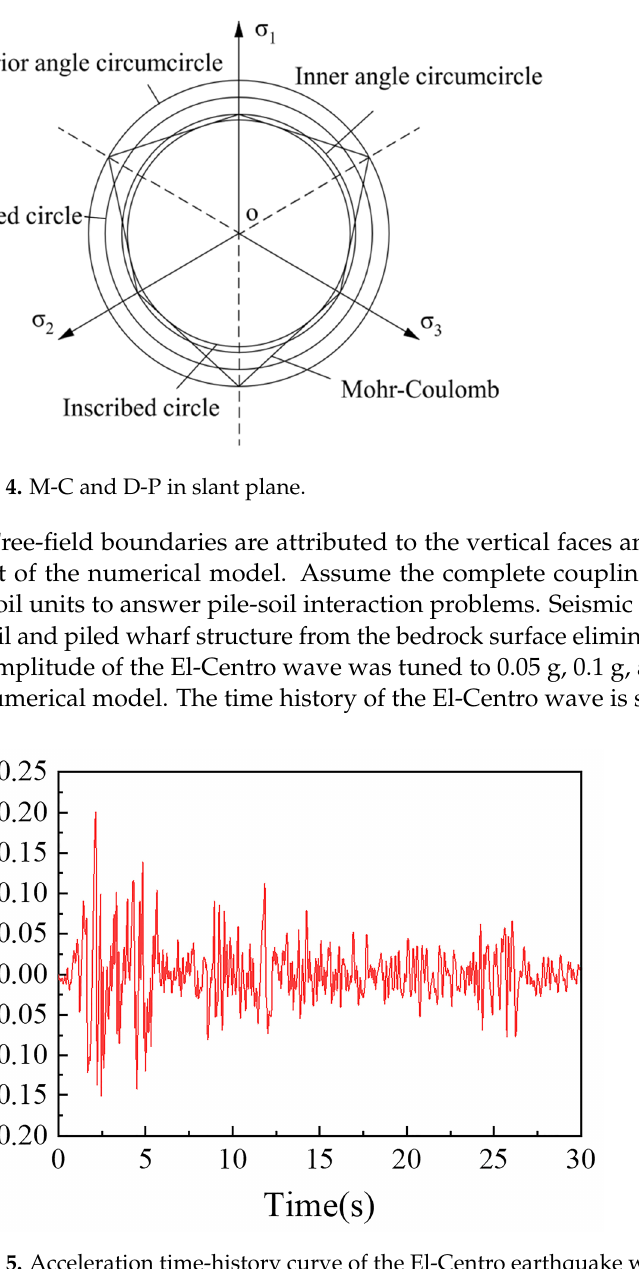
Figure 5. Acceleration time-history curve of the El-Centro earthquake wave.